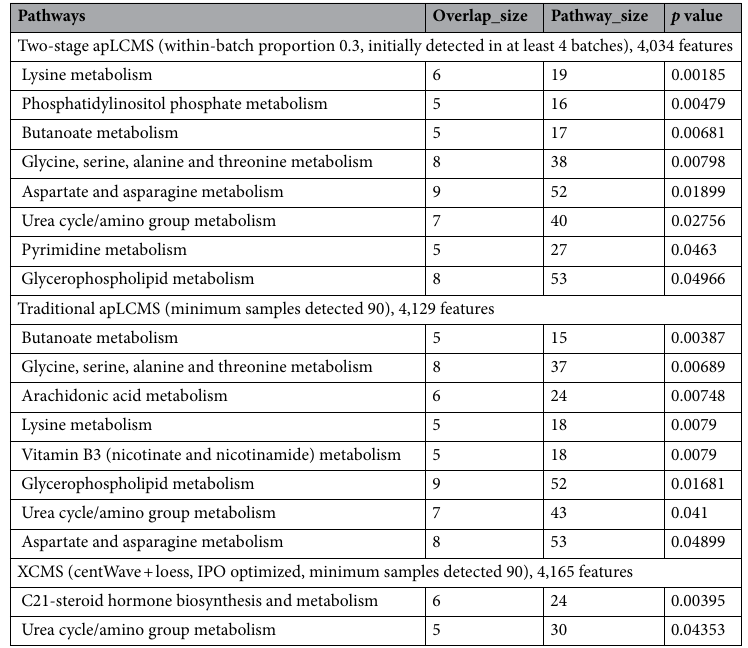
Table 2. Significant pathways with at least 5 matched significant metabolic features for parameter settings where ~ 4,000 features were detected.